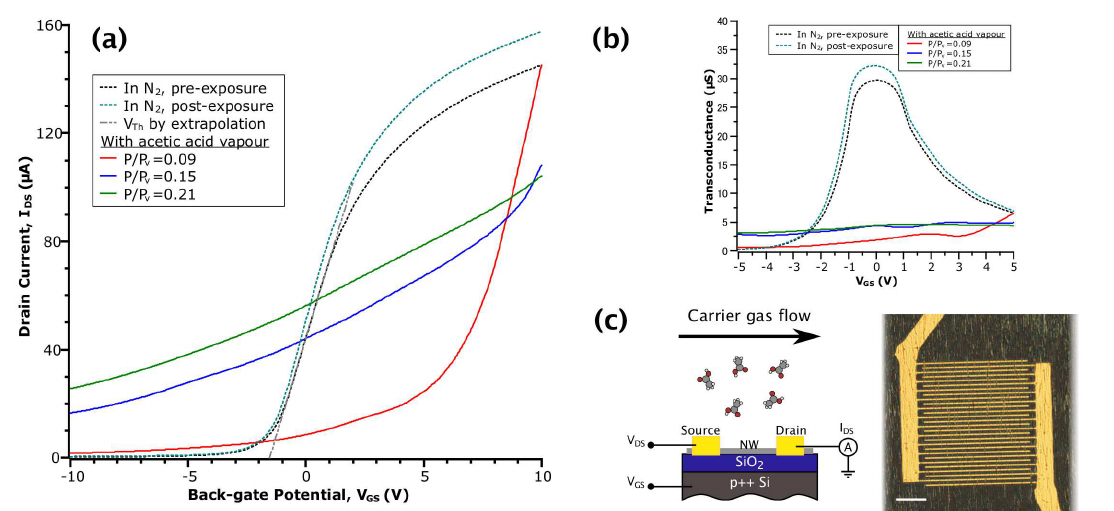
Figure 1. ( a ) I DS - V GS curves of InAs nanowire FET (NWFET) in various environments. The grey dashed line shows the method of obtaining V Th by extrapolation of a linear fit; ( b ) Transconductance versus V GS obtained by numerical differentiation of the data in (a); ( c ) Schematic diagram of the NWFET structure (left) and optical micrograph of the device (right) with a scale bar of